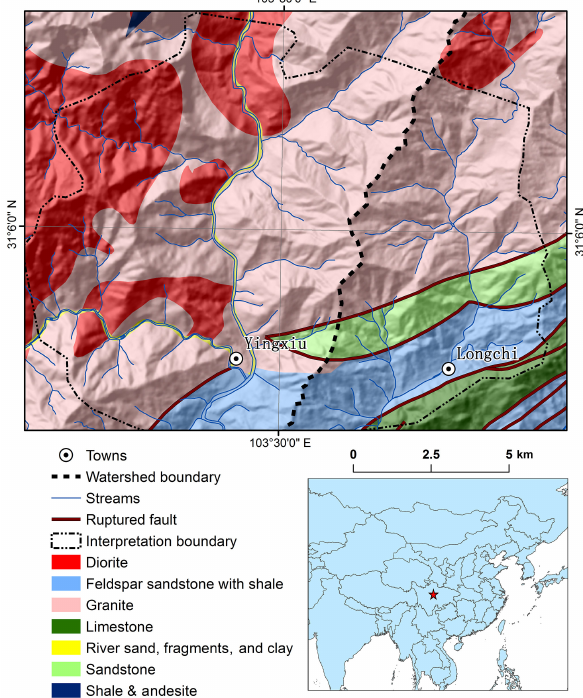
Figure 1. Map of the study area. The western part of the thick dotted line is the Yingxiu area and the eastern part is the Longchi area. The area for which the landslide interpretation was carried out is shown as a polygon with a thin dotted